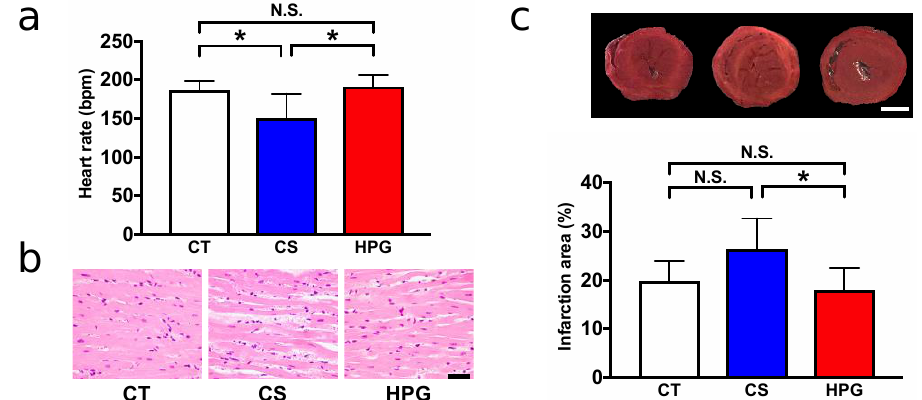
Figure 1. Assessment of transplanted hearts after 24-h preservation in three groups: control group (CT), nonpreservation; cold storage (CS) group, preservation in the University of Wisconsin (UW) solution for 24 h; high-pressure gas (HPG) group, preservation using the mixture of high-pressure carbon monoxide (CO) and oxygen (O 2 ) for 24 h. ( a ) Heart rate at 60 min after transplantation. ( b ) Hematoxylin and eosin staining in transplanted hearts after 24-h preservation. Black bar represents 40 µ m. ( c ) Representative midmyocardial cross-sections of 2,3,5-triphenyltetrazolium chloride-stained hearts. Red-stained areas indicate viable tissues, and white areas indicate infarct tissues. White bar represents 500 µ m. Myocardial infarction areas in the hearts of each group were quantified. Data in each bar are presented as mean ± standard error of the mean. N.S., not significant. * p < 0.05. P -values were calculated by one-way ANOVA with post hoc Tukey’s multiple comparison analysis.